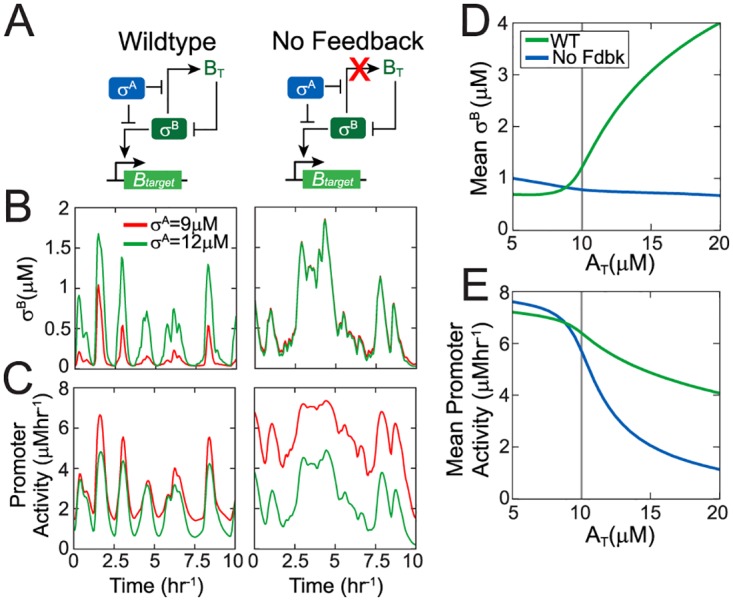
Negative feedback insulates the σB response from competition with houskeeping σ-factor σA.A. Simplified network diagrams of stress σ-factor σB competing with housekeeping σ-factor σA for RNA polymerase. In all cases, a σB phosphatase controls the stress-signal driven activation of σB. (B,C). Trajectories of free σB (B) and σB target promoter activity (C) in response to stochastic phosphatase input for both networks at two different levels of σA (σA = 9μM—low competition-regime and σA = 12μM—high-competition regime for RNA polymerase). D-E. Mean free σB concentration (D) and mean σB target promoter activity (E) as a function of total σA concentration (AT) for both networks in (A) at fixed mean phosphatase (mean PT = 0.5 μM). Gray vertical line shows the total RNA polymerase level which was fixed at 10 μM.